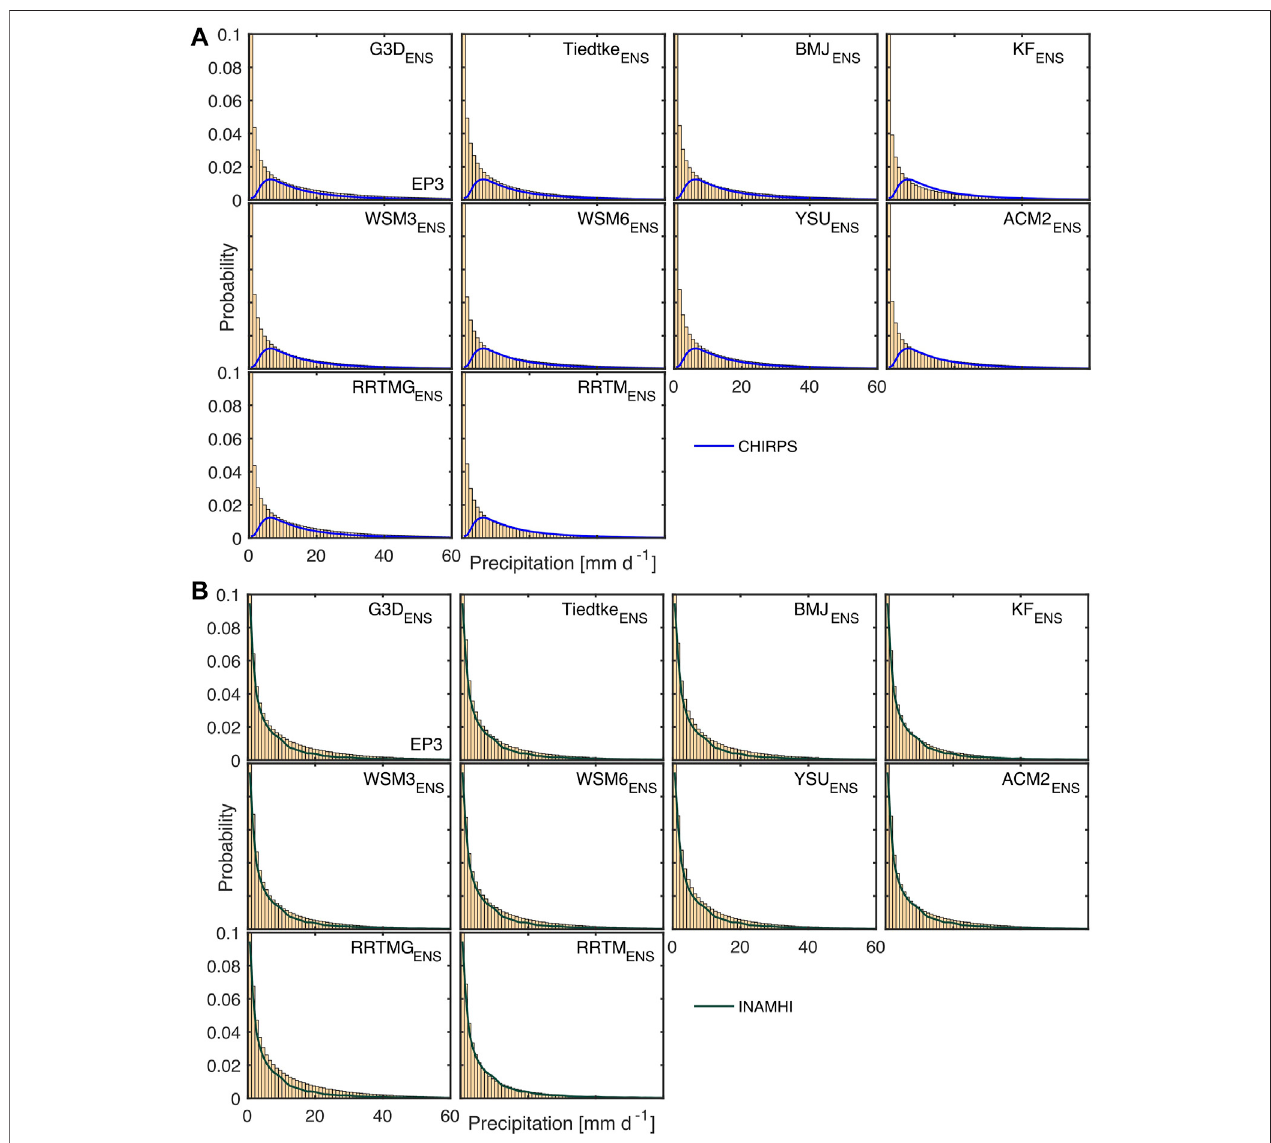
FIGURE 7 | As Figure 6 , but for EP3, with (A) CHIRPS reference data and (B) INAMHI station data. For (B) , WRF data interpolated to the location of the 106 selected stations was used.